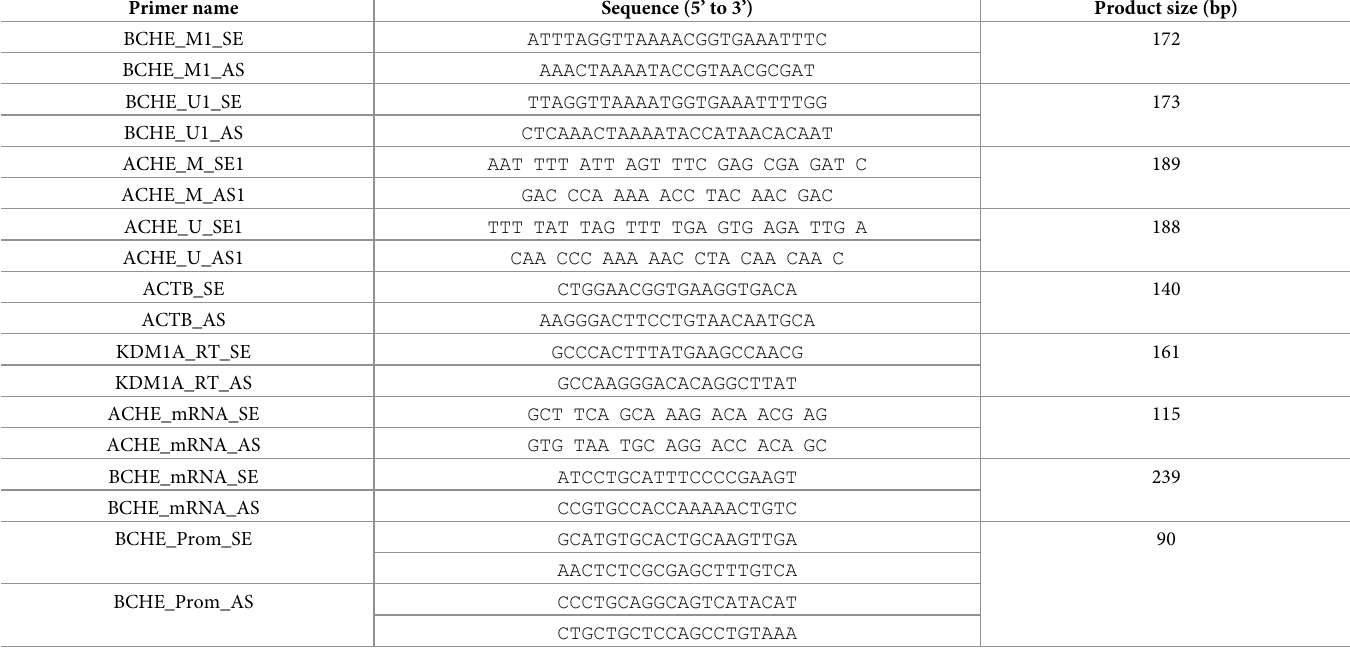
Table 1. Primer pairs for